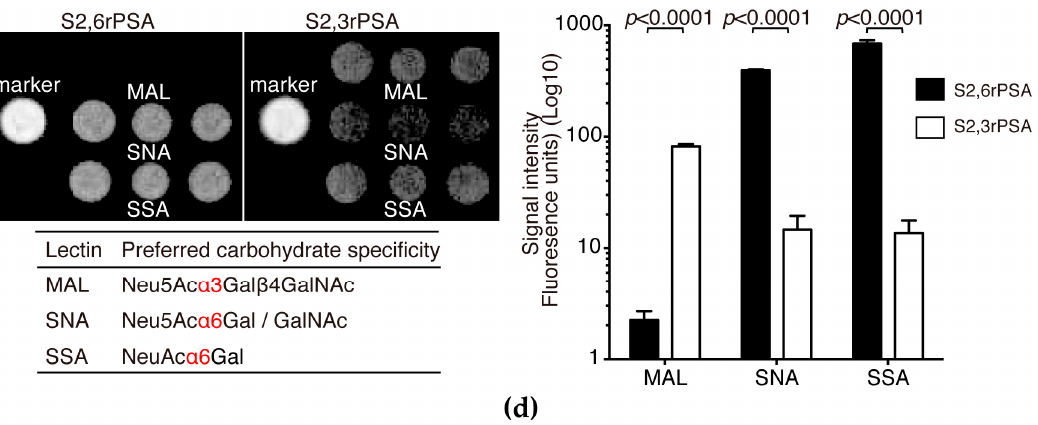
Figure 2. Preparation of α 2,3-linked sialyl N -glycan-carrying PSA (S2,3PSA) and α 2,6-linked sialyl N -glycan-carrying PSA (S2,6PSA) in Chinese hamster ovary (CHO)-K1 cells transfected with PSA–FLAG. CHO-K1 cells were transfected with FLAG-tag-fused human PSA cDNA (PSA–FLAG). ( a ) Culture supernatant (CS) with serum free media were blotted onto polyvinylidene fluoride (PVDF) membrane and probed with anti-FLAG antibodies; ( b ) Chromatograms obtained using Agrocybe cylindracea (ACG) lectin column chromatography for α 2,3-linked sialyl N -glycan-carrying recombinant PSA (S2,3rPSA) collected from 0.2 M lactose eluted fraction and other glyco-isoform free PSA containing α 2,6-linked sialyl N -glycan (S2,6rPSA) or asialo-type N -glycan collected from washed fraction. S2,3rPSA and S2,6PSA was further purified by gel filtration column chromatography; ( c ) Washed fraction (lane 1) and 0.2 M lactose-eluted fraction (lane 2) (indicating chromatogram) ( b ) were blotted onto PVDF membrane and probed with anti-FLAG antibodies; ( d ) Lectin array profiling of S2,3rPSA and S2,6rPSA proteins. Purified S2,3rPSA and S2,6rPSA was applied to the lectin array, including triplicate spots. The glass slides were scanned using a GlycoStationReader1200 (Glycotechnica, Sapporo, Japan). MWM: molecular weight markers; MAL: Mackkia amurensis lectin; SNA: Sambucus Nigra lectin; SSA: Sambucus sieboldiana lectin.